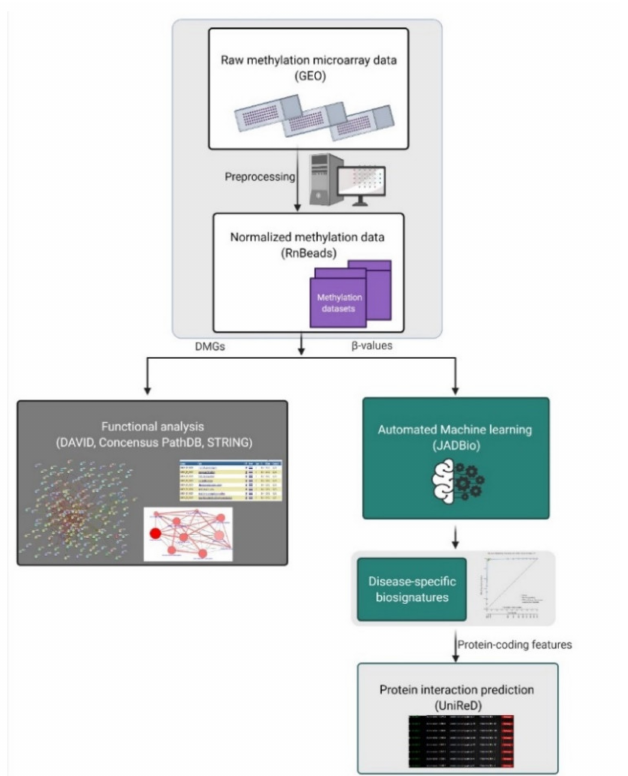
Figure 7. Study workflow. Abbreviations: DMGs = differentially methylated genes, GEO = Gene Expression Omnibus. Created with BioRender.com, accessed on 20 July